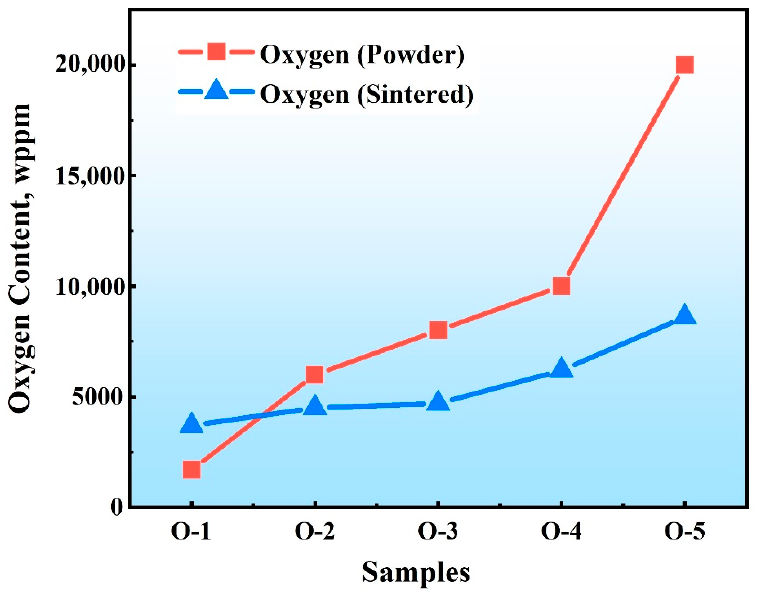
Figure 4. O content in powder and sintered samples during powder metallurgy preparation.